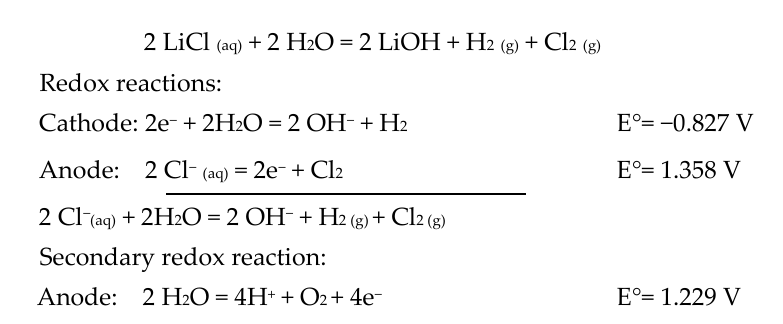
Figure 1. Diagram of membrane electrodialysis cell to obtain Lithium hydroxide.